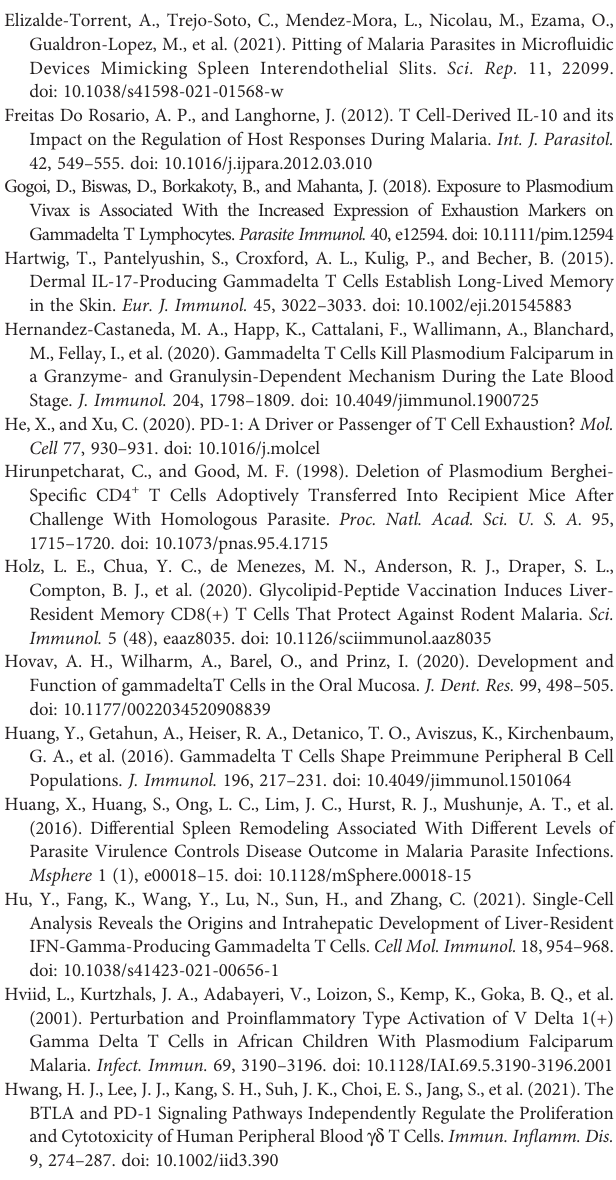
Additional fi le 1: Table S1 | Information on the marker genes in each cluster. Additional fi le 2: Figure S1 | (A – C) At 14 days after P. yoelii NSM infection, blood samples from each group of mice were collected. The numbers of WBCs, RBCs, and PLTs in the blood were measured. Representative results of three independent results are shown (N=5) and the error bars are SD. **** P < 0.0001, *** P < 0.001, ** P < 0.01, * P < 0.05. Additional fi le 3: Figure S2 | The supplementary data for fl ow cytometry. (A) The FCM plots of distribution and content of CD4 + T cells and CD8 + T cells in the two infected and two naive groups. (B, C) The FCM plots of expression levels of activated markers on CD4 + T cells and CD8 + T cells in P. yoelii NSM infected mice compared with the two naive groups. (D, E) The FCM plots of expression levels of cytokines on CD4 + T cells and CD8 + T cells. (F) The FCM plots of percentage and content of B cells in each group of mice. (G) The FCM plots of expression levels of activated markers on B cells in P. yoelii NSM infected mice compared with the two naive